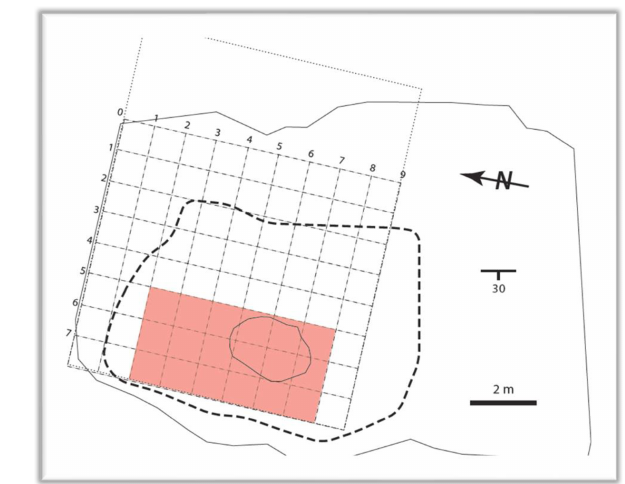
Figure 3. Grid layout used to take photographs. The grid spacing is 1m, and photos were taken from each grid intersection with a camera aimed into the target grid space. The shaded area shows the area we processed for this study, and the heavy dashed line outlines the map area from Kappus et al. (2011).